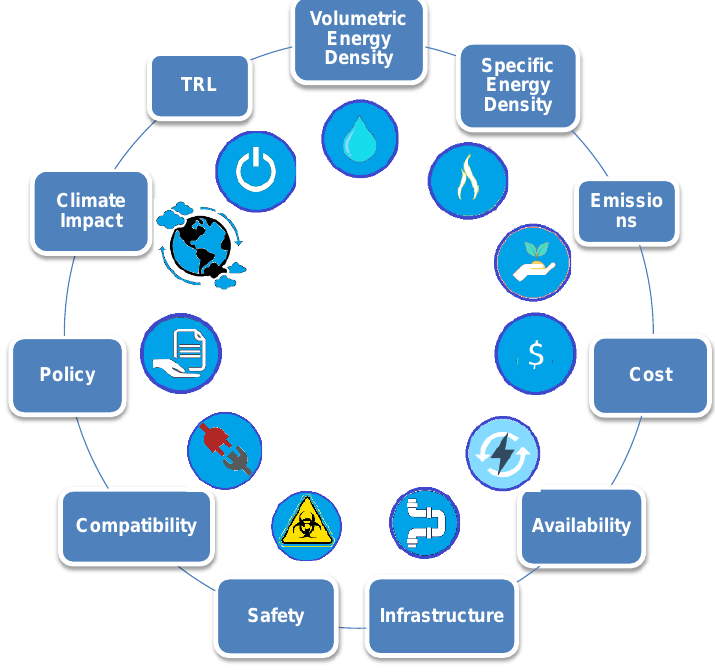
Figure 8. Some of the important considerations during the selection of alternative fuel / energy carriers in aviation.